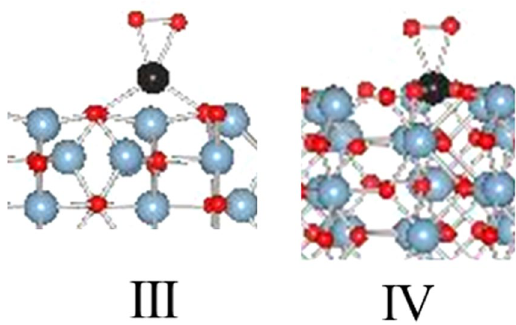
Figure 6. The interaction of single supported Pd atoms with